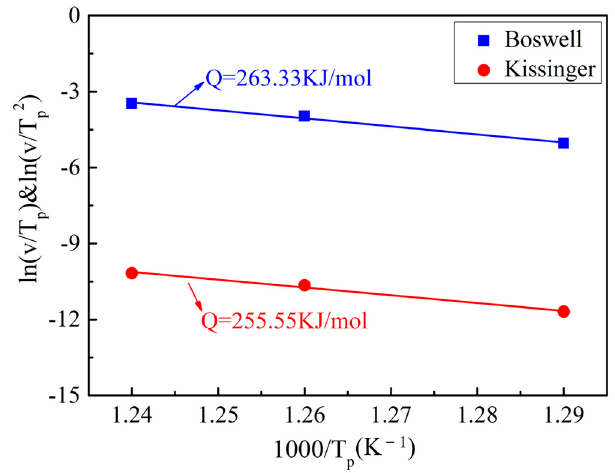
Figure 11. Recrystallization activation energy of the UFG TiFeB alloy determined by DSC.